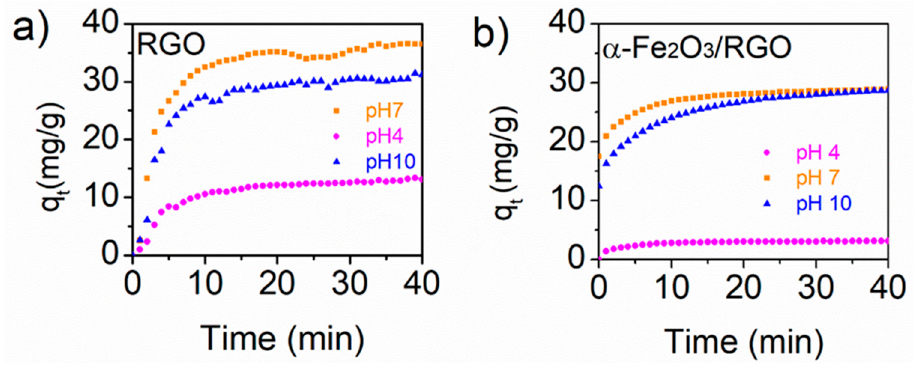
Figure 5. ( a ) Kinetic adsorption of tetracycline on RGO and ( b ) on α -Fe 2 O 3 /RGO hybrid material as a function of pH.